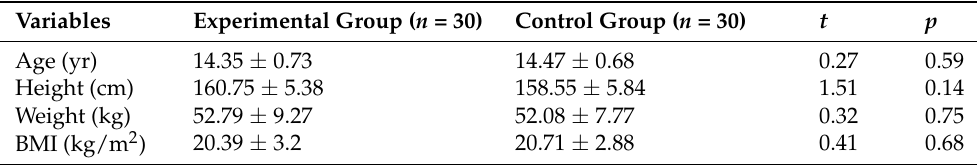
Table 1. Study participants’ characteristics at